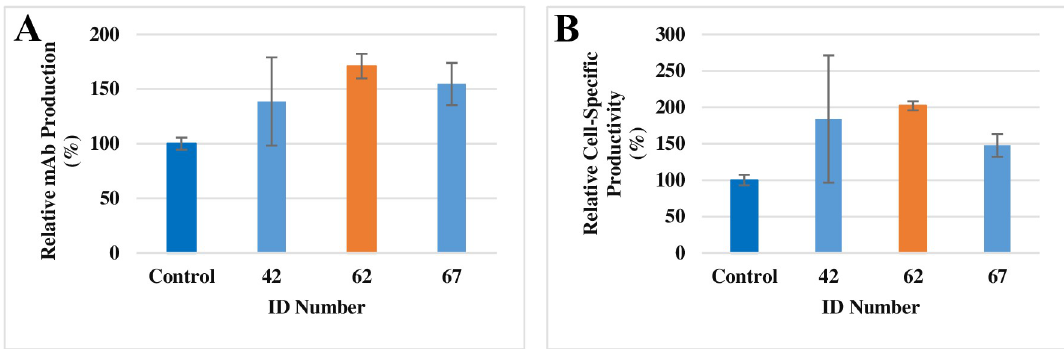
Fig 3. The effect of the three candidate compounds on relative mAb concentration and relative cell-specific productivity. All cell cultures were executed three times and evaluated on day 3. Each value of relative mAb production ( A ) and relative cell-specific productivity ( B ) were compared